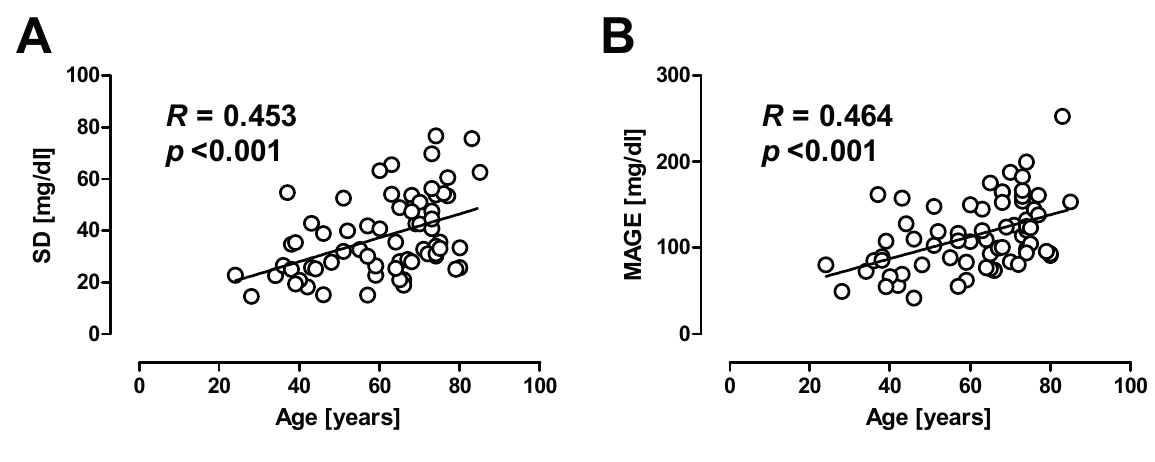
Figure 4. Correlation between age and ( A ) standard deviation (SD) or ( B ) mean amplitude of glycemic excursions (MAGE) assessed by CGM in patients with T2DM. Reproduced with permission from the Japan Diabetes Society